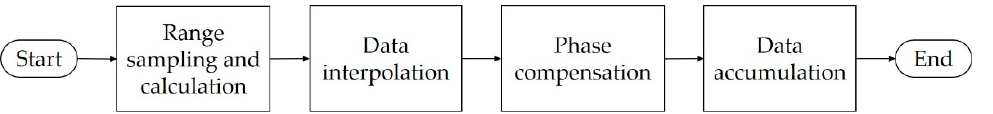
Figure 5. Flowchart of the process for computing child synthetic aperture radar (SAR) data. Range samples are collected along a line defined by the center of the child subaperture r n ( k ) and the center of the child subimage (cid:101) h n , c . A sample is always taken at (cid:101) h n , c ; except for the last iteration, other samples are taken along the diameter of the sphere that circumscribes the child subimage, as depicted in Figure 6. The range sampling interval is the same for all iterations. It is calculated in the preparation step, shown in Figure 1a, and is equal to the resulting range bin spacing after upsampling the root SAR data.